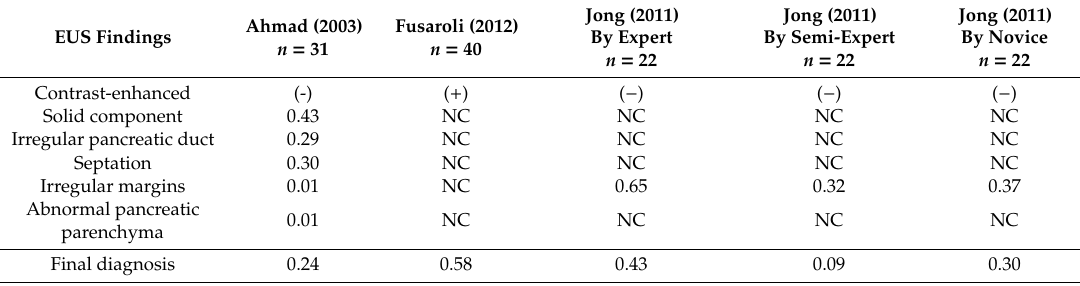
Table 3. Interobserver reliability of EUS criteria for solid pancreatic lesion and pancreatic cystic lesion. EUS